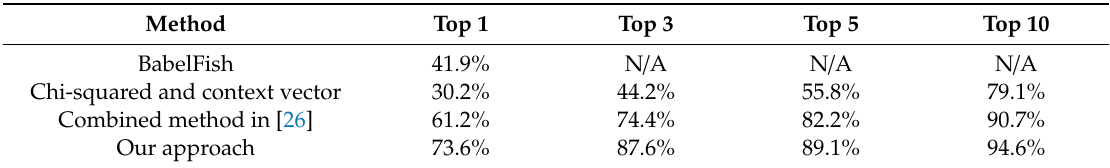
Table 3. Top n inclusion rates of term translations mined using machine translation and translation based on web